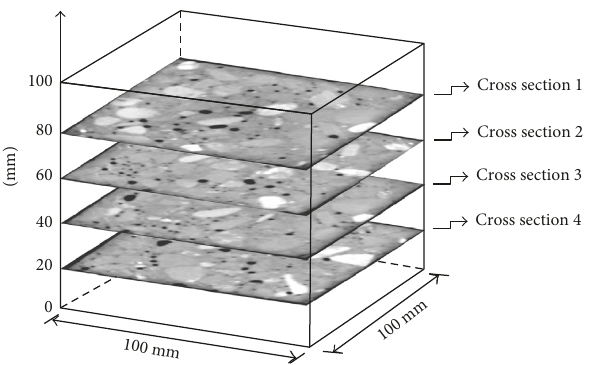
Figure 6: Location of scanning cross section.